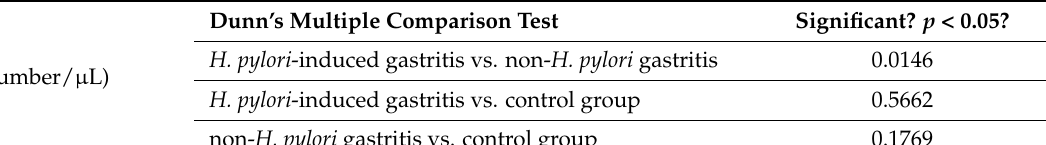
Table 5. The difference of median values of neutrophils between the three groups.